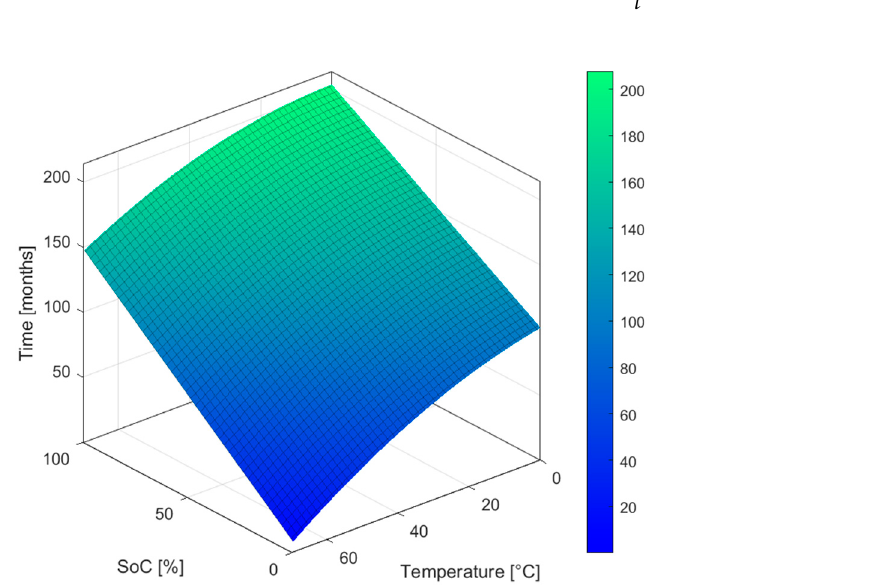
Figure 5. The expected calendar life, expressed in months of the LiC at various SOCs and tempera- tures, for an EOL criterion of a 20% capacity fade.